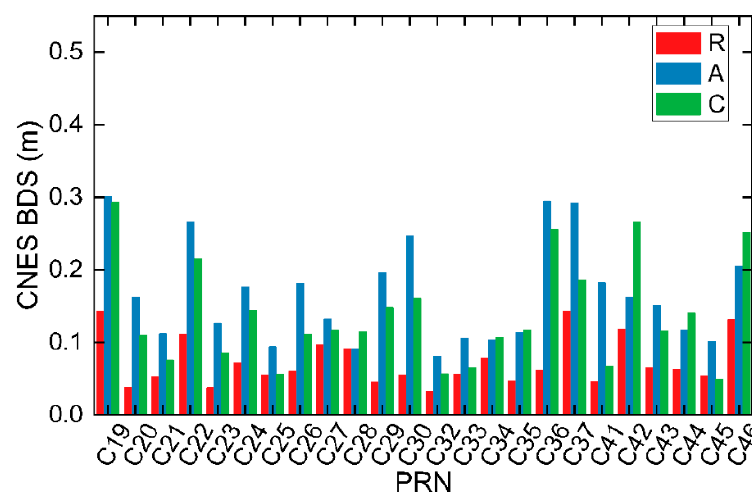
Figure 4. RMSEs of the CNES orbits for BDS-3 satellites.